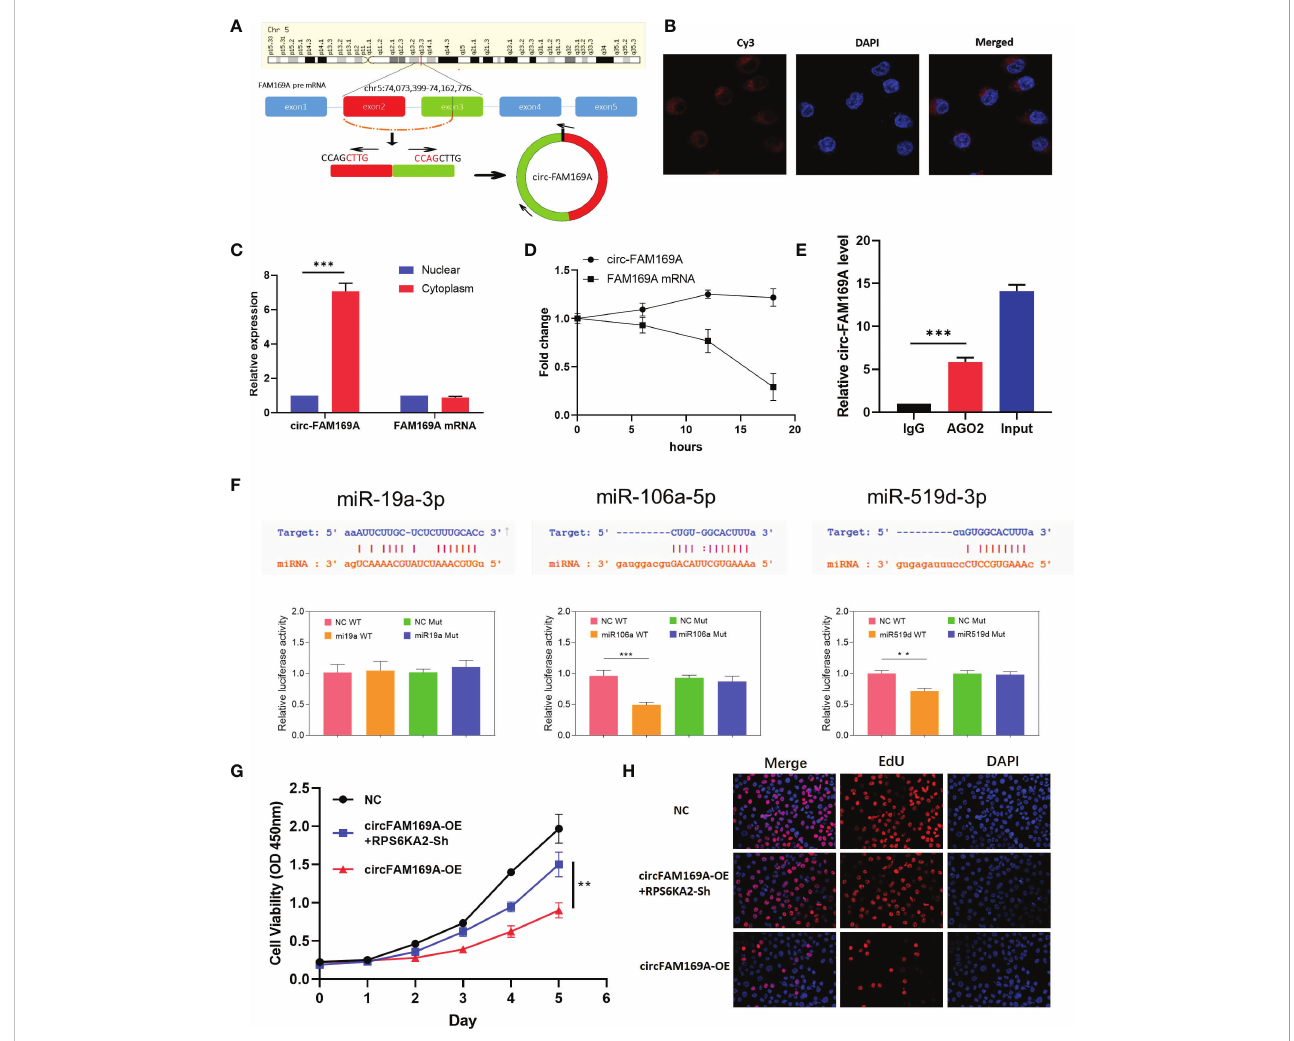
FIGURE 6 circFAM169A was the sponge of miR-106a-5p and miR-519d-3p. (A) The genomic loci of circFAM169A in FAM169A mRNA. (B, C) The location of circFAM169A was detected by FISH assay and nucleoplasmic separation assay. (D) qRT-PCR of circFAM169A and FAM169A mRNA during differentiation. (E) Enrichment of circFAM169A by AGO2 antibody and IgG was assessed by RIP assay. (F) Dual-Luciferase reporter assays were performed to verify the predicted sites between circFAM169A and miRNAs. (G, H) Cell proliferative ability was assessed by CCK-8 assay and EdU assay. (** indicates p<0.01, *** indicates